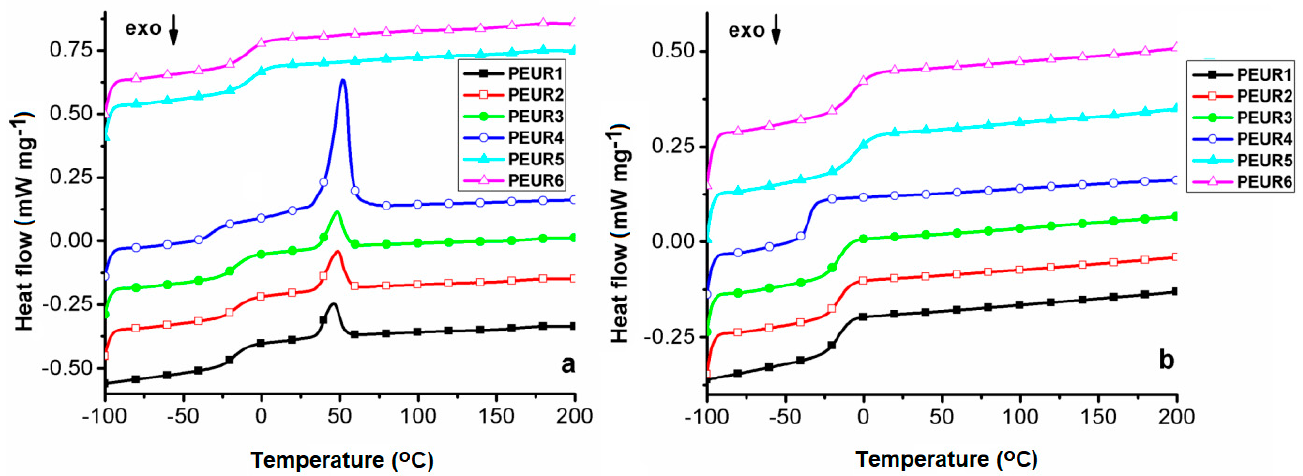
Figure 7. DSC first heating ( a ) and second heating ( b ) curves of the aged PEURs. Data extracted from the DSC measurements are given in Table 4. The DSC heating curves present only the glass transition temperature ( T g ), associated with the soft segments, from − 33 to − 5 ◦ C on the first heating, and from − 35 to − 7 ◦ C on the second heating, due to little influence from hard segment domains and/or cross-linking. The lowest T g values were recorded for the sample PEUR4. This signifies that PEUR4 ′ s longer chain components endow the structure not only with enhanced cross-linking capacity, as shown from TGA data, but also with flexibility, due to more free volume between chain segments. As expected, the highest T g values correspond to the more rigid aromatic structures of the PEUR5 and PEUR6 structures. Table 4. Data extracted from TG, DTG and DSC curves.